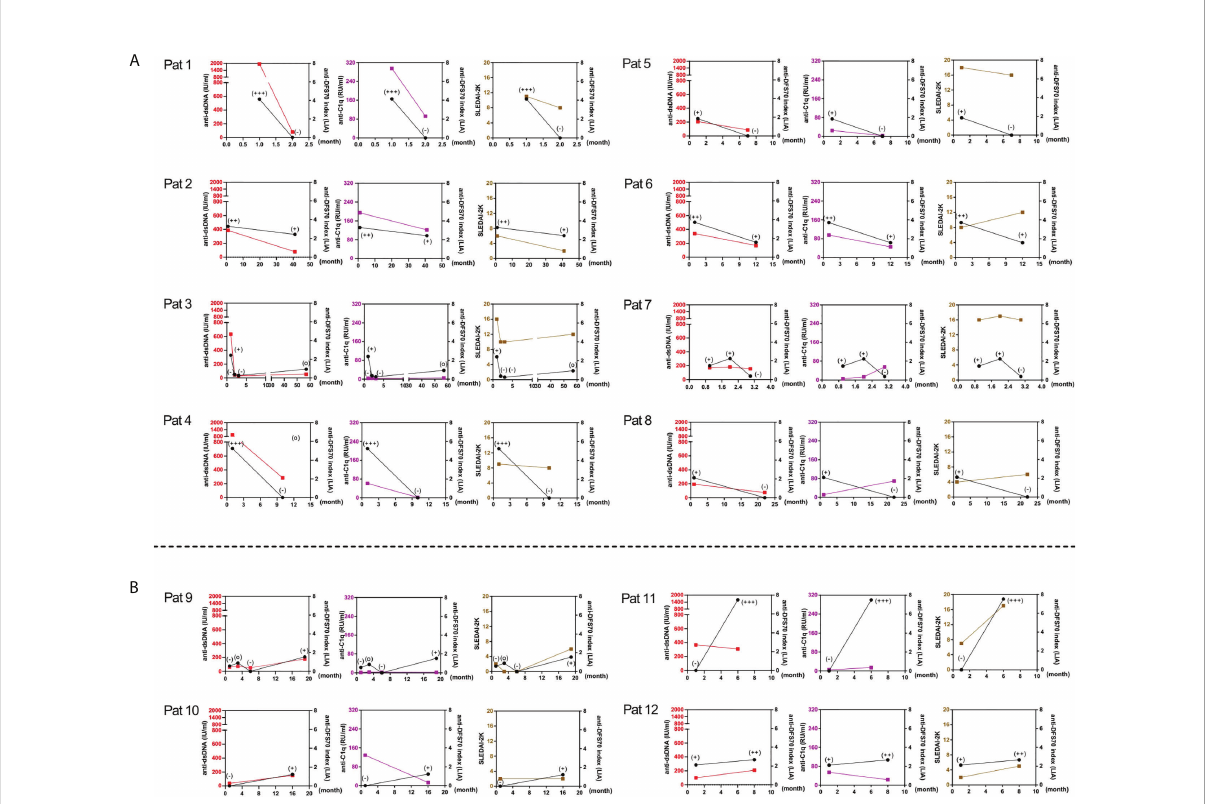
FIGURE 4 Variations of the levels of anti-dsDNA, anti-C1q antibodies, and SLEDAI-2K in 12 SLE follow-up patients having signi fi cant changes of anti-DFS70 antibodies by LIA. Signi fi cant changes in the levels of anti-DFS70 antibodies, including the conversion between positive and negative, and changed one or more positive levels within the intensity classi fi cation scheme of LIA. The upper and lower panels respectively show patients with decreasing and increasing results of anti-DFS70 antibodies by LIA from the fi rst visit to the last visit during the follow-up. (A) In patients with a downtrend of anti-DFS70 antibodies (Pat 1-8), a similar variation trend was observed between anti-DFS70 and anti-dsDNA in seven of eight patients except for Pat 7. A similar variation trend was observed between anti-DFS70 and anti-C1q in fi ve of eight patients except for Pat 3, Pat 7, and Pat 8. A similar variation trend was observed between anti-DFS70 and SLEDAI-2K in four of eight patients except for Pat 4, Pat 6, Pat 7, and Pat 8. (B) In patients with an upward trend of anti-DFS70 antibodies (Pat 9 – 12), a similar variation trend was observed between anti- DFS70 and anti-dsDNA in three of four patients except for Pat 11. No similar variation trend was observed between anti-DFS70 and anti-C1q. A similar variation trend was observed between anti-DFS70 and SLEDAI-2K in three of four patients, except for Pat 10. Red, anti-dsDNA; purple, anti-C1q; brown, SLEDAI-2K; black, anti-DFS70; x -axis, time points of measurement (the time point of the fi rst visit was set as 1). Classi fi cation of line intensity by LIA: index 0 – 0.79, intensity ( − ), negative; index 0.8 – 1.14; intensity (o), borderline; index 1.15 – 2.49, intensity (+), weak